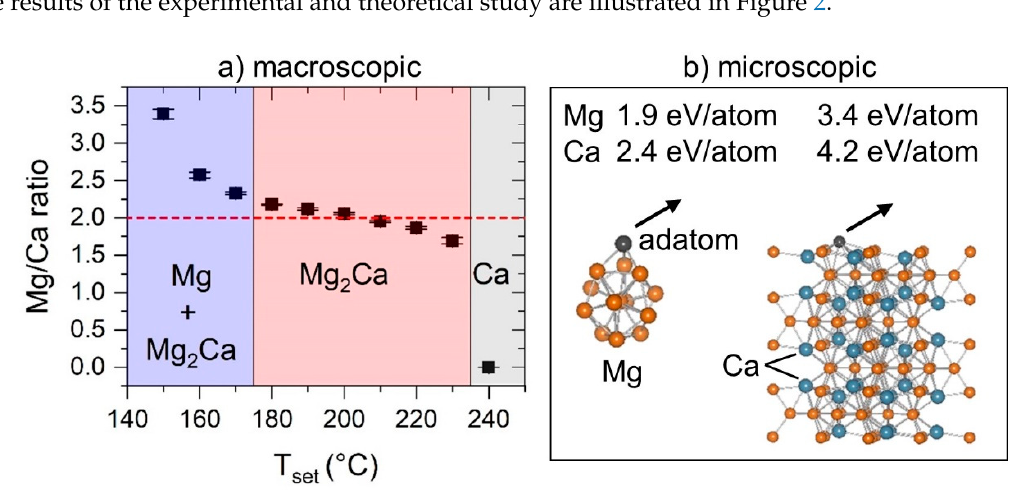
Figure 2. ( a ) Measured Mg/Ca ratio (EDX) of the as-deposited Mg–Ca thin films as a function of the set temperature between 150 and 240 °C. Obtained error bars lie within the data points. The horizontal dashed line indicates the stoichiometry of Mg 2 Ca. The temperature ranges are highlighted according to the obtained phases by X-ray diffraction. ( b ) Desorption energies of Mg and Ca (adatoms) from Mg (left) and from Mg 2 Ca (right) nanoclusters are calculated. Arrows indicate the desorbing Mg and Ca adatoms.